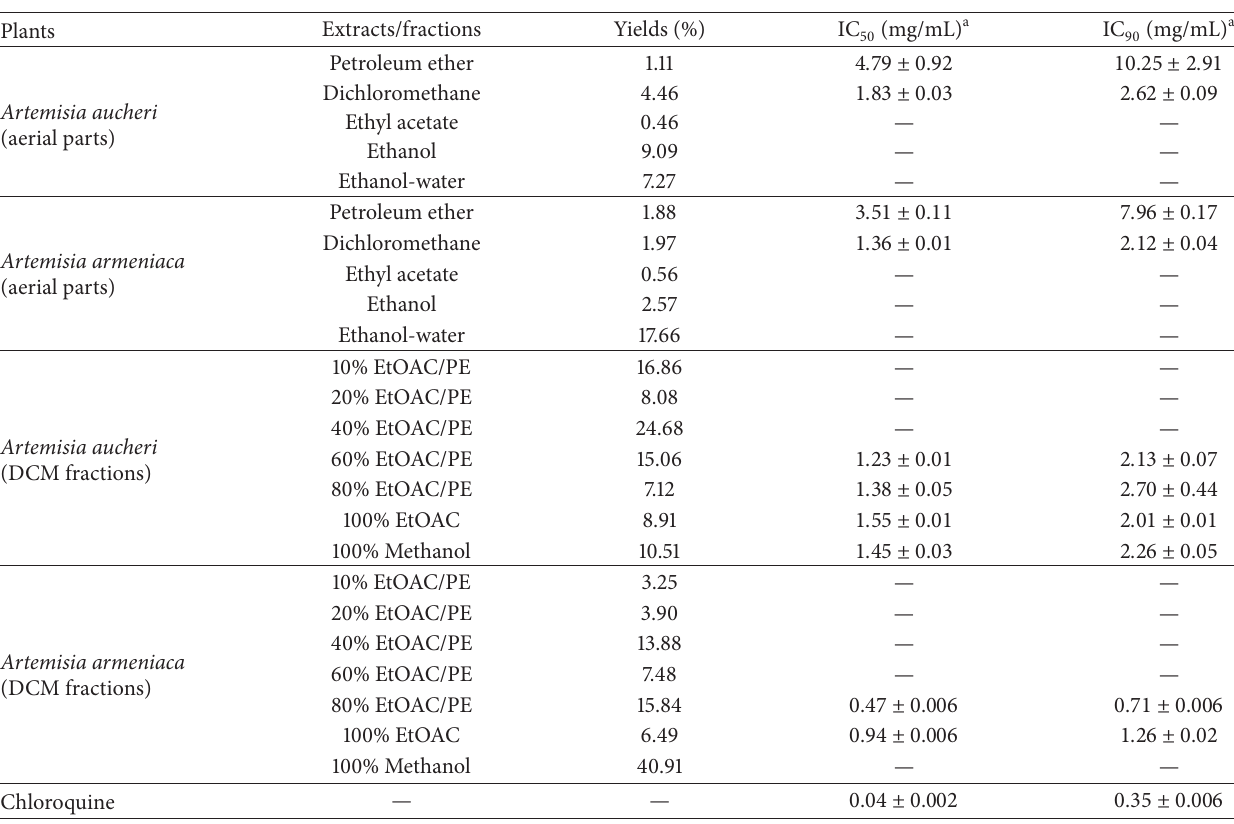
Table 1: The 50% and 90% inhibition concentrations (mg/mL) of different extracts and fractions of A. armeniaca and A. aucheri in 𝛽 -hematin formation assay.